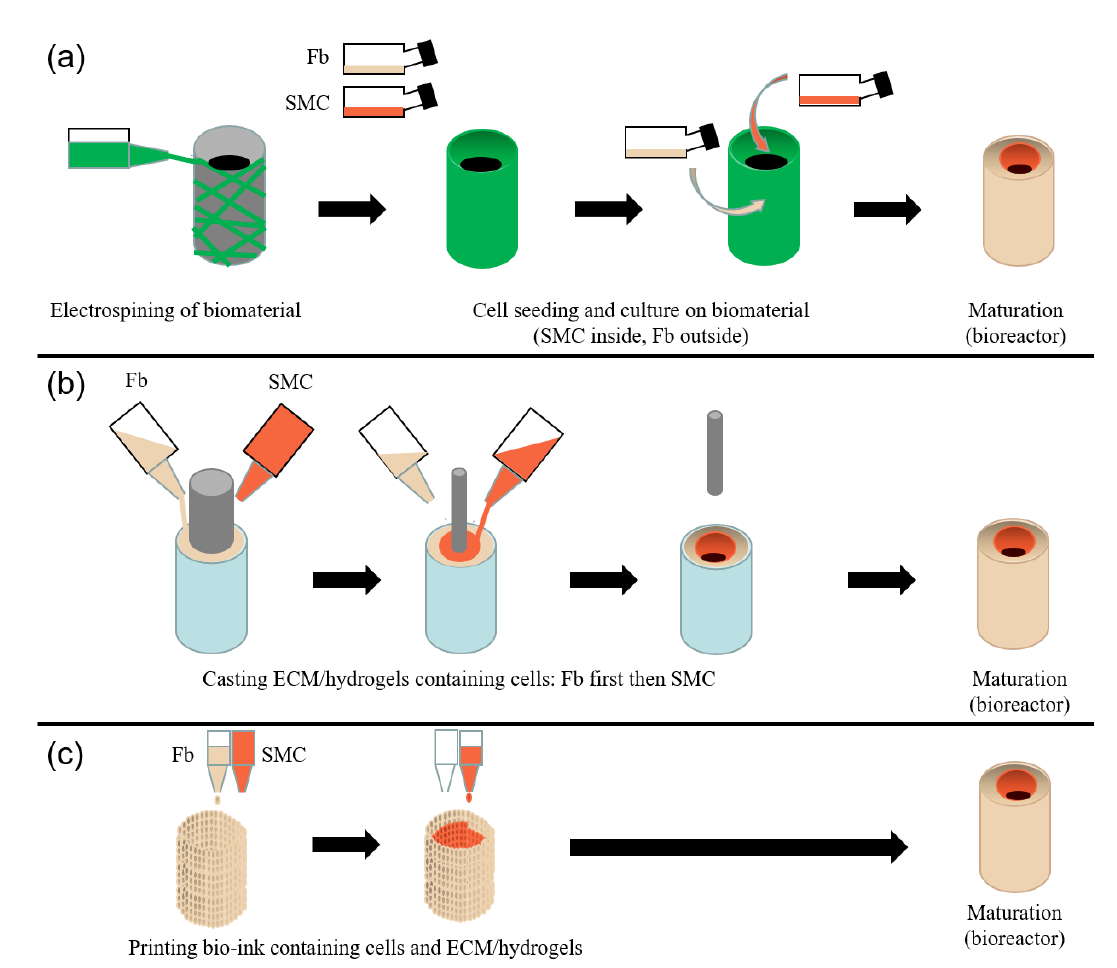
Figure 2. Principal techniques to produce vascular tubular structures. ( a ): Electrospinning; ( b ): Casting in a mold; ( c ): Bioprinting.